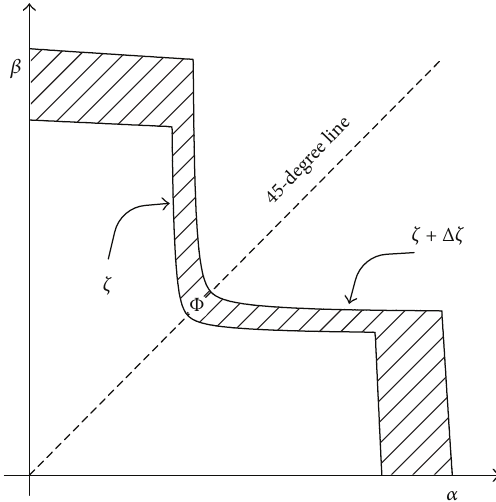
Figure 17: Region Φ between two isopower curves over which a double integral is to be